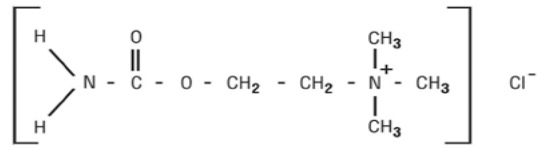
Figure 2. The chemical structure of carbachol chloride.